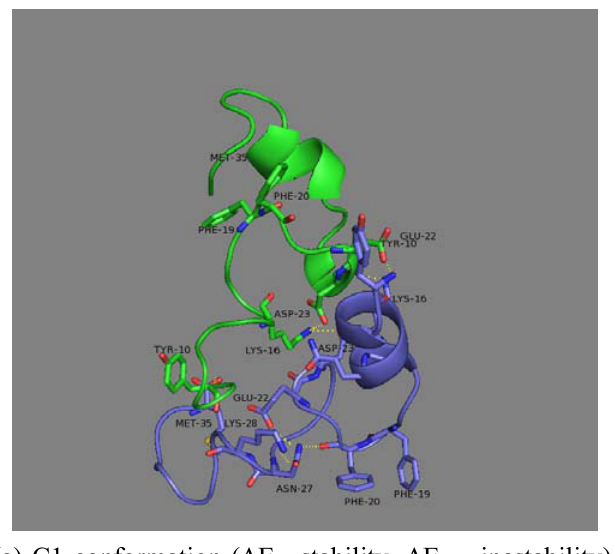
Prototype structure at the energy barrier at stage